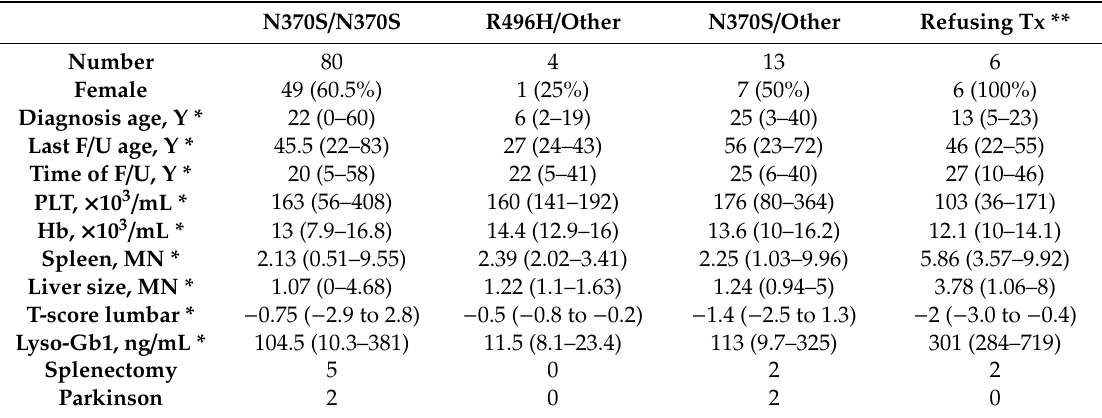
Table 1. Characteristic of untreated patients with type I Gaucher disease at last follow-up. N370S /